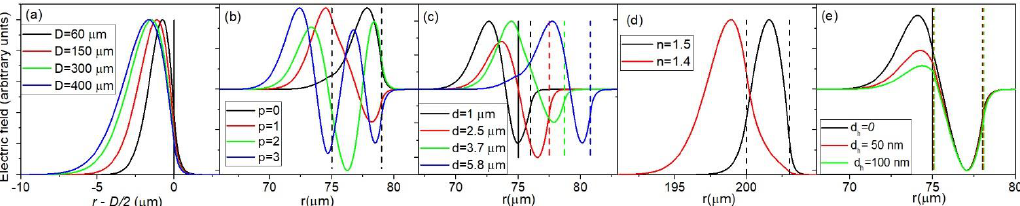
Figure 2. The dependence of ∂λ / ∂ n c ( left ) and n eff for l = m ( right ) on d for n c = 1.4 calculated for select values of p and D .